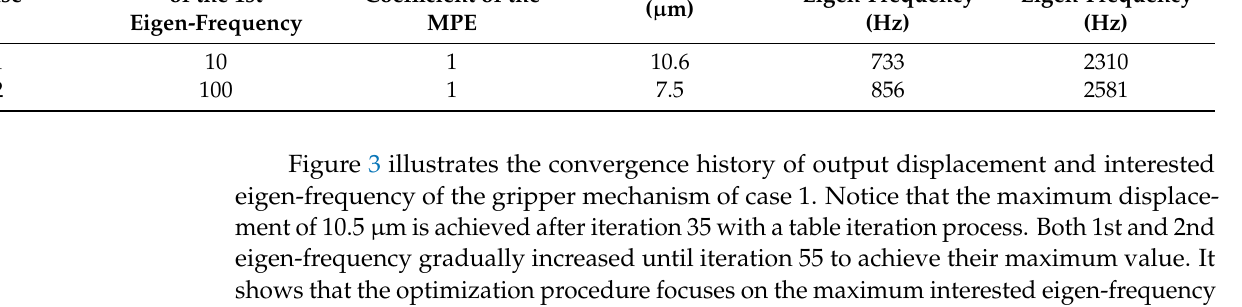
Table 1. Two types of optimized result with different weighting coefficient of the 1st eigen-frequency.